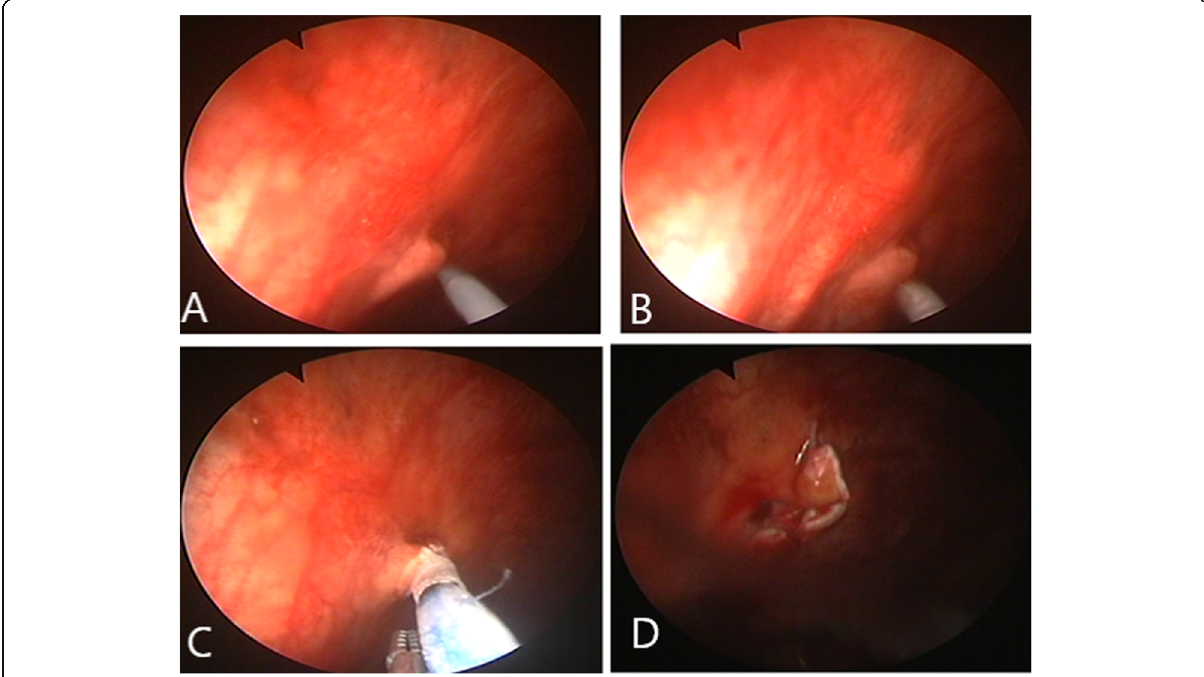
Fig. 1 Steps of the modified thoracoscopic cryo-biopsy technique. a Insertion of the needle. b Injection of mixed saline and adrenaline subpleurally. c Insertion of the cryoprobe and attaching to the target area of the parietal pleura forming the ice-ball (note that the cryoprobe is attached to a rigid forceps). d Getting the